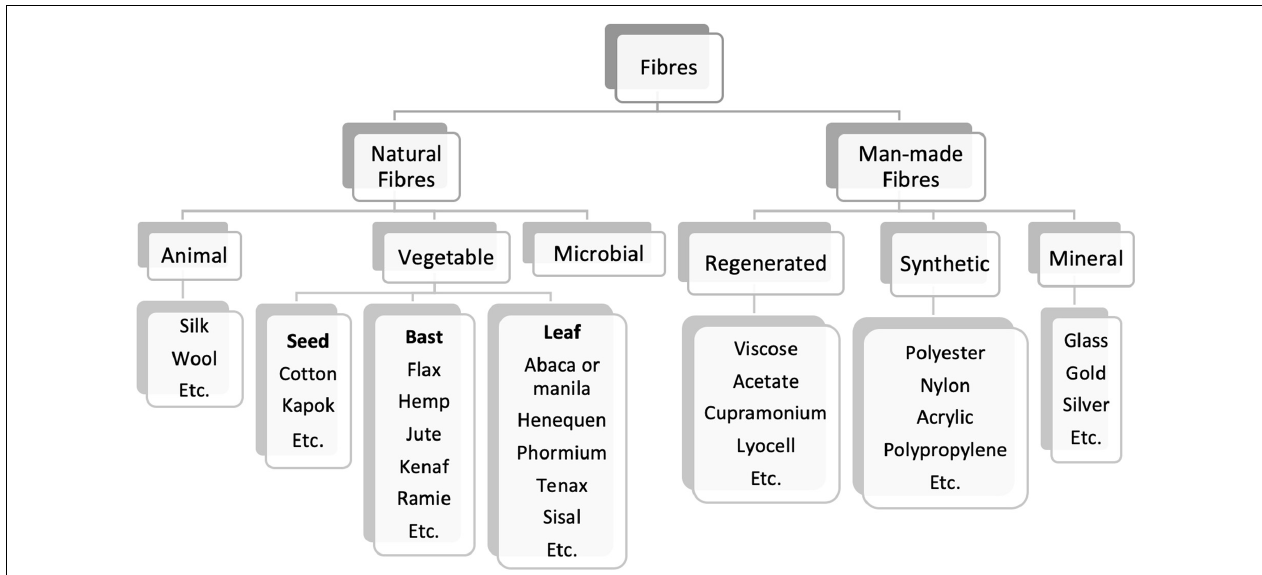
FIGURE 1 | Classification of main natural and man-made fibers [adapted from Murthy (2016), Sinclair (2015)].